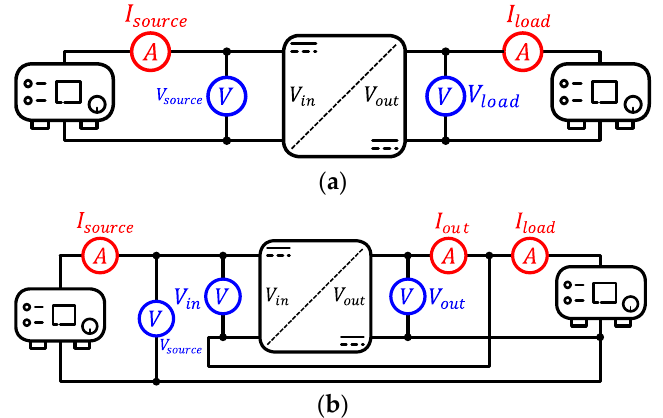
Figure 13. Simplified electric circuit of the experimental set-up. ( a ) DAB-FPP; ( b ) DAB-PPP.